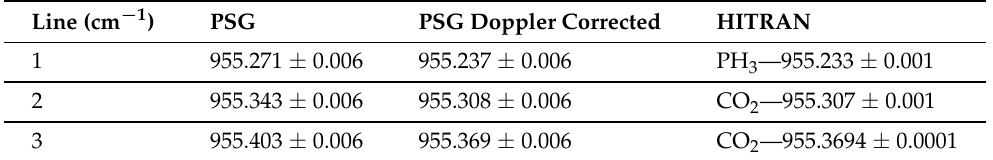
Table 3. Phosphine on Venus—line identification: 955.15–955.4 cm − 1 . See Figure 10. The position of the lines agrees with the positions reported in HITRAN [56,67,70]. The uncertainty of the line positions in the simulation derive from the resolution of the simulation ( ∼ 0.012 cm − 1 ).